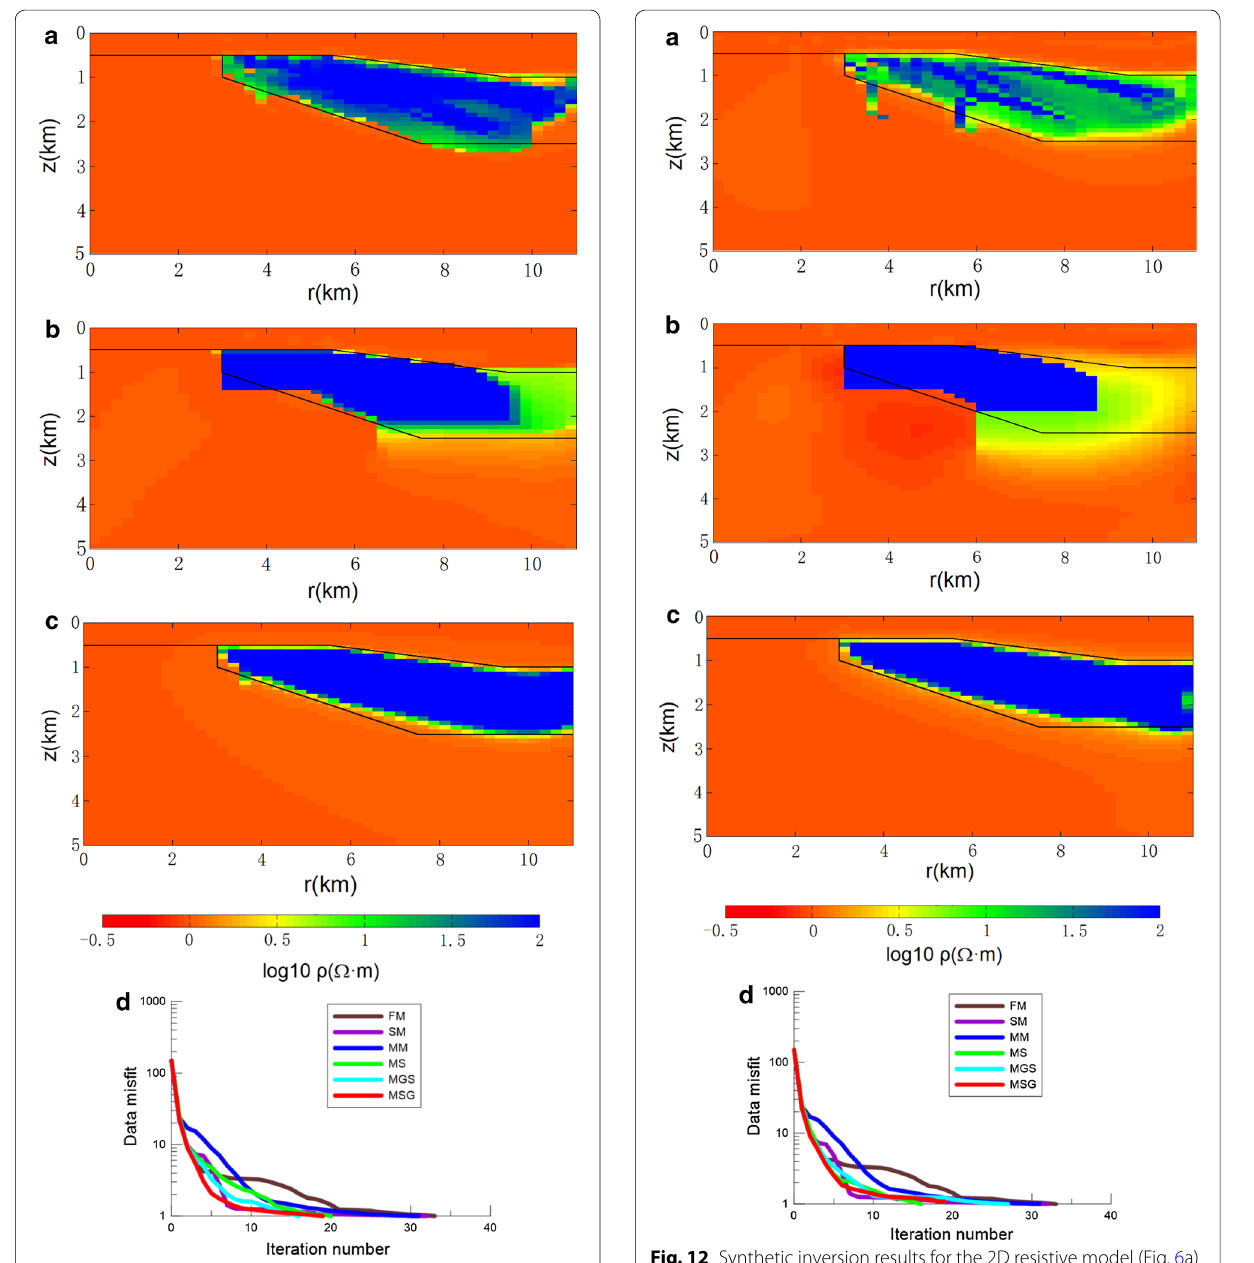
0.01: a MS, b MGS, c =